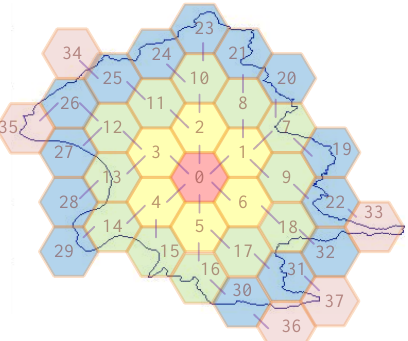
Figure 3. Example of Cell Allocation to an area. The allocation is started from c 0 . In each iteration, some cells will be allocated. After five iterations, the allocation is finished.